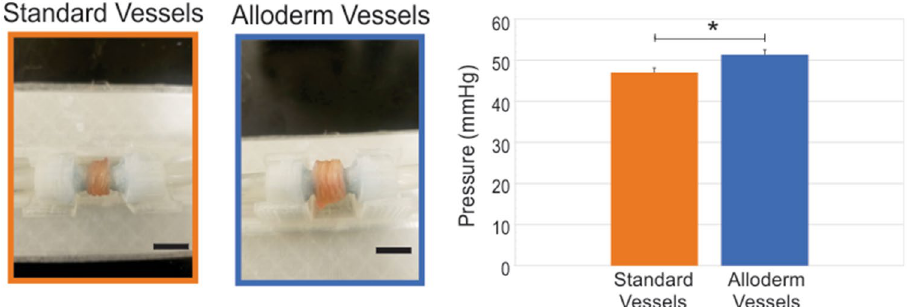
Figure 8. Burst pressure testing of engineered vessels. Standard vessels without (n = 5) and with Alloderm (n = 5) were placed under increasing pulsatile flow until failure. Vessels are shown loaded into the custom perfusion system used to perform the burst pressure tests. Alloderm vessels had significantly higher burst pressure compared to vessels without Alloderm (*p < 0.005). Scale bars = 1 cm.